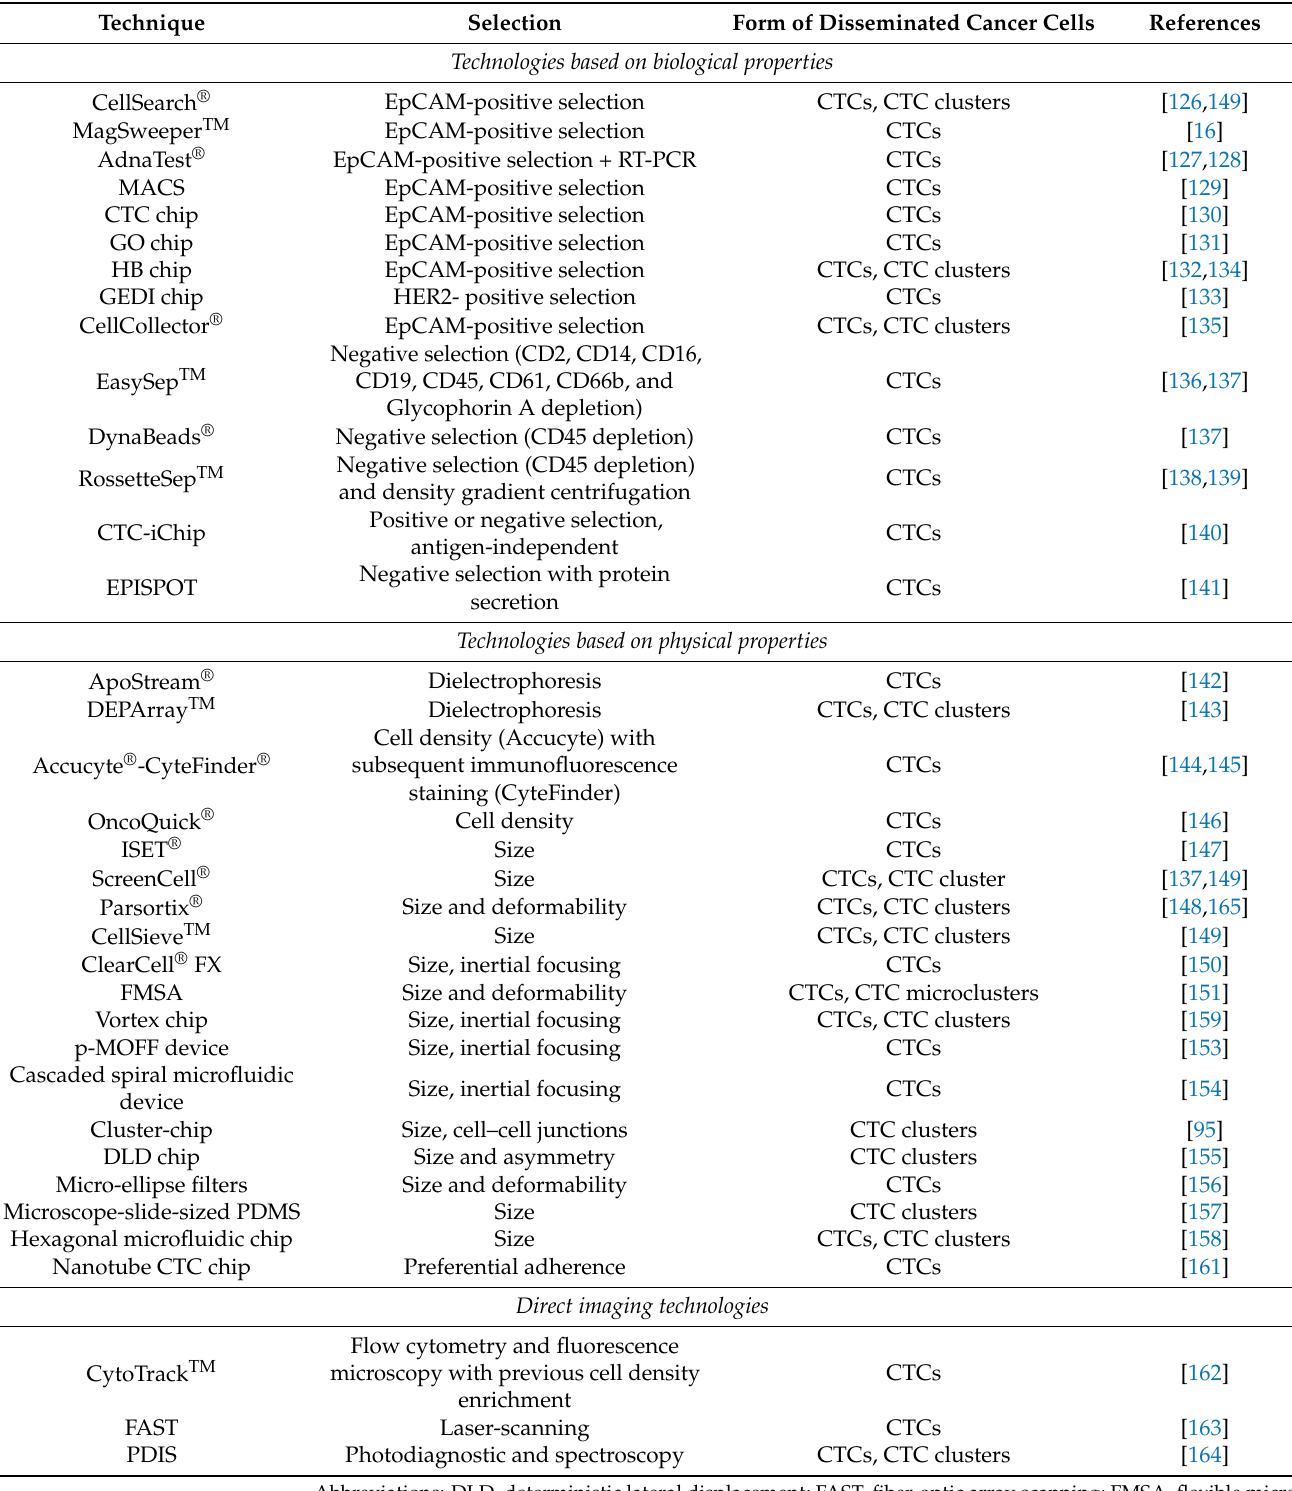
Table 1. Single CTCs and/or CTC clusters detection technologies in breast cancer clinical